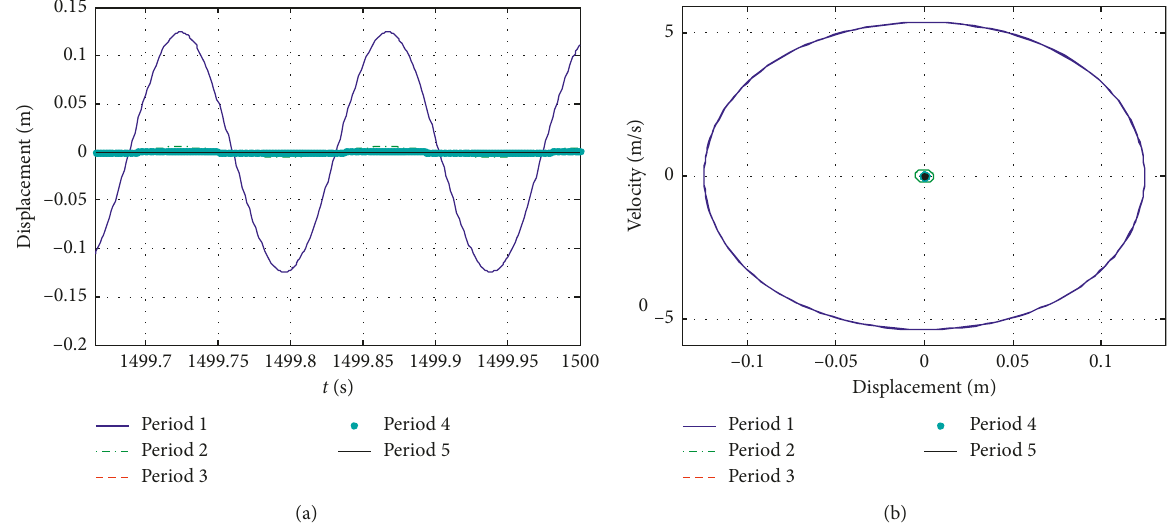
Figure 9: Five periodic oscillators’ (a) displacement time history curves and (b) phase diagrams (effective negative